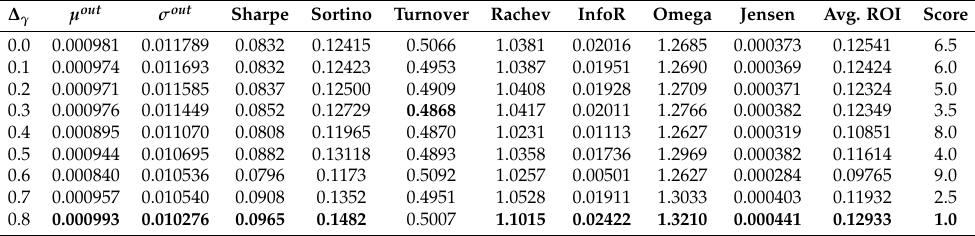
Table 18. CIB: out-of-sample performance results for the KP R strategy by varying ∆ γ .